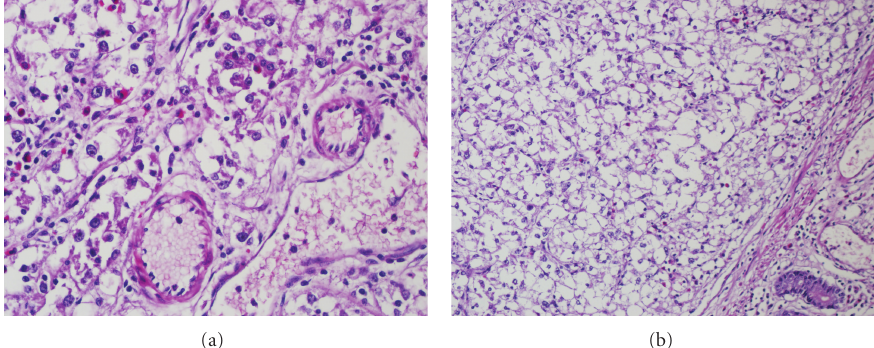
Figure 2: (a) Perivascular tumor cells with clear to slightly eosinophilic granular cytoplasm and round vesicular nuclei, (b) submucosal tumor mass.